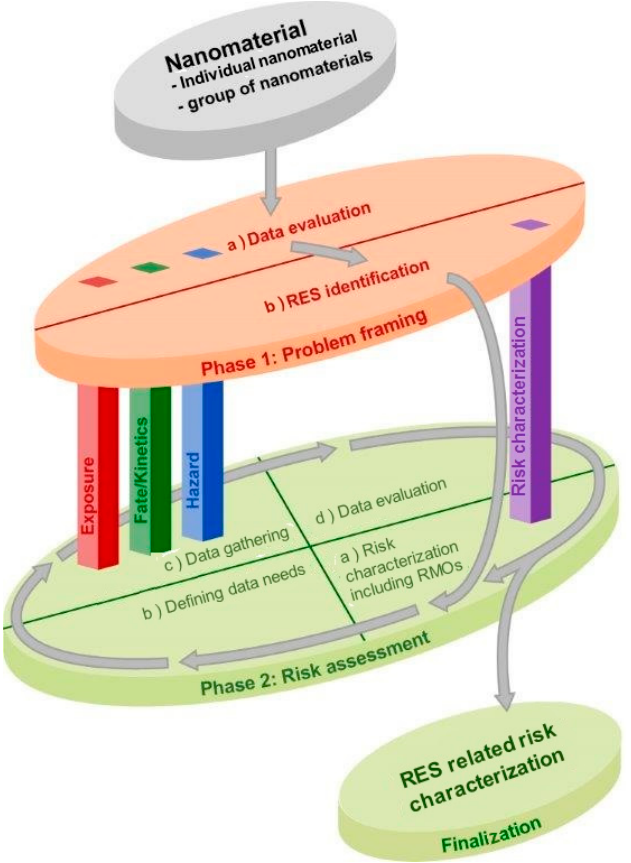
Figure 1. Schematic overview of the MARINA Risk Assessment Strategy, consisting of: (1) an overarching “Phase 1: Problem framing” (orange disc); (2) the iterative “Phase 2: Risk assessment” (green discs: cyclic evaluation process and a finalization step); (3) the three information-gathering pillars: Exposure (red), Fate/Kinetics (green) and Hazard (blue) and (4) the Risk characterization pillar (purple). Phase 1 consists of two steps: (a) Data evaluation; and (b) identification of Relevant Exposure Scenarios (RESs).